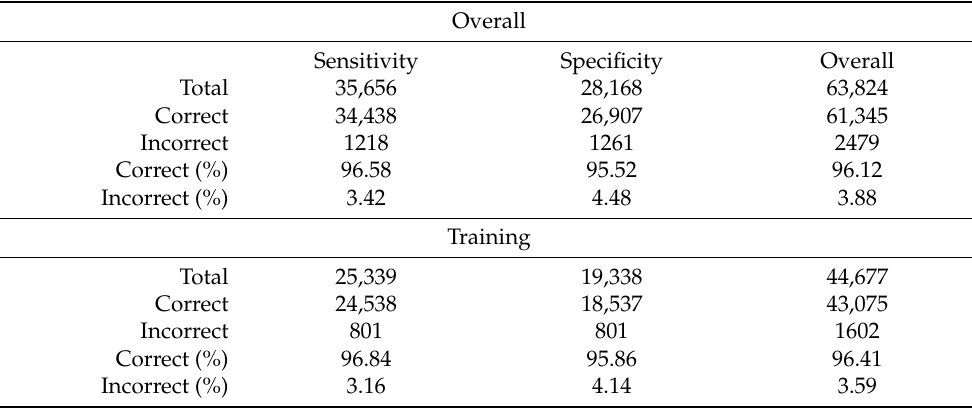
Table 2. Statistics for the best ANN